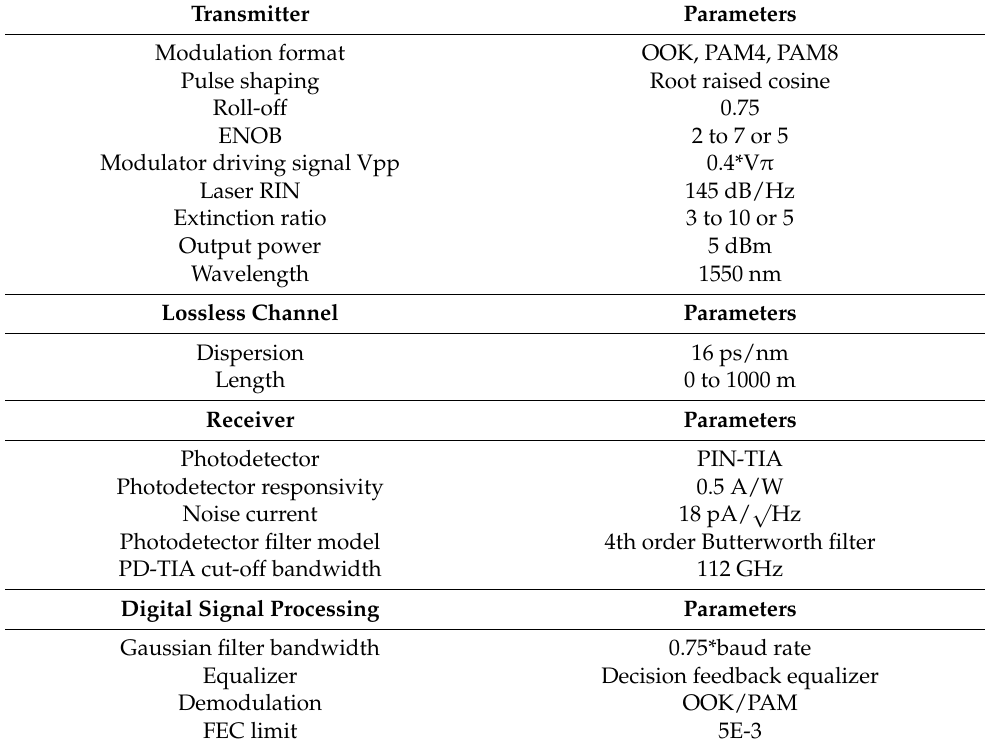
Table 1. Simulation setup